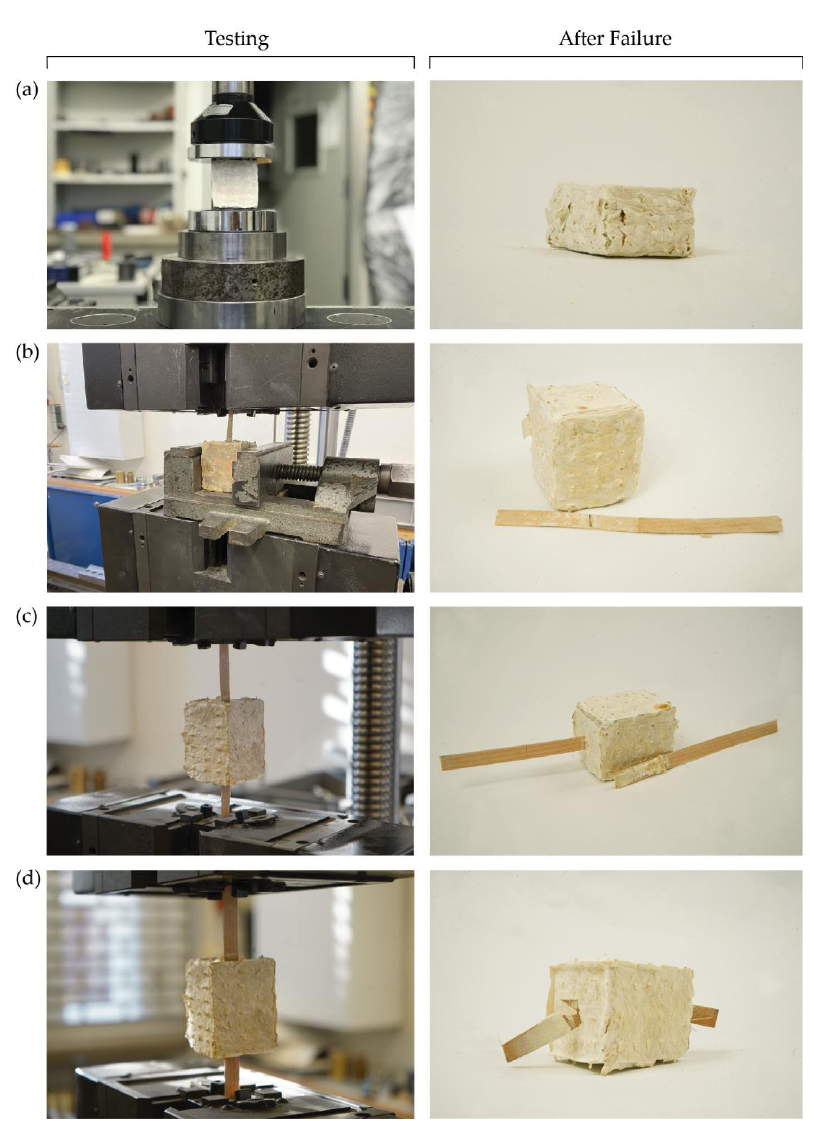
Figure 7 . Samples during testing and after failure: ( a ) Compressive strength test; ( b ) One-side veneer pull-out test; ( c ) Two-side unwelded veneer pull-out test; ( d ) Two-side welded veneer tensile test.